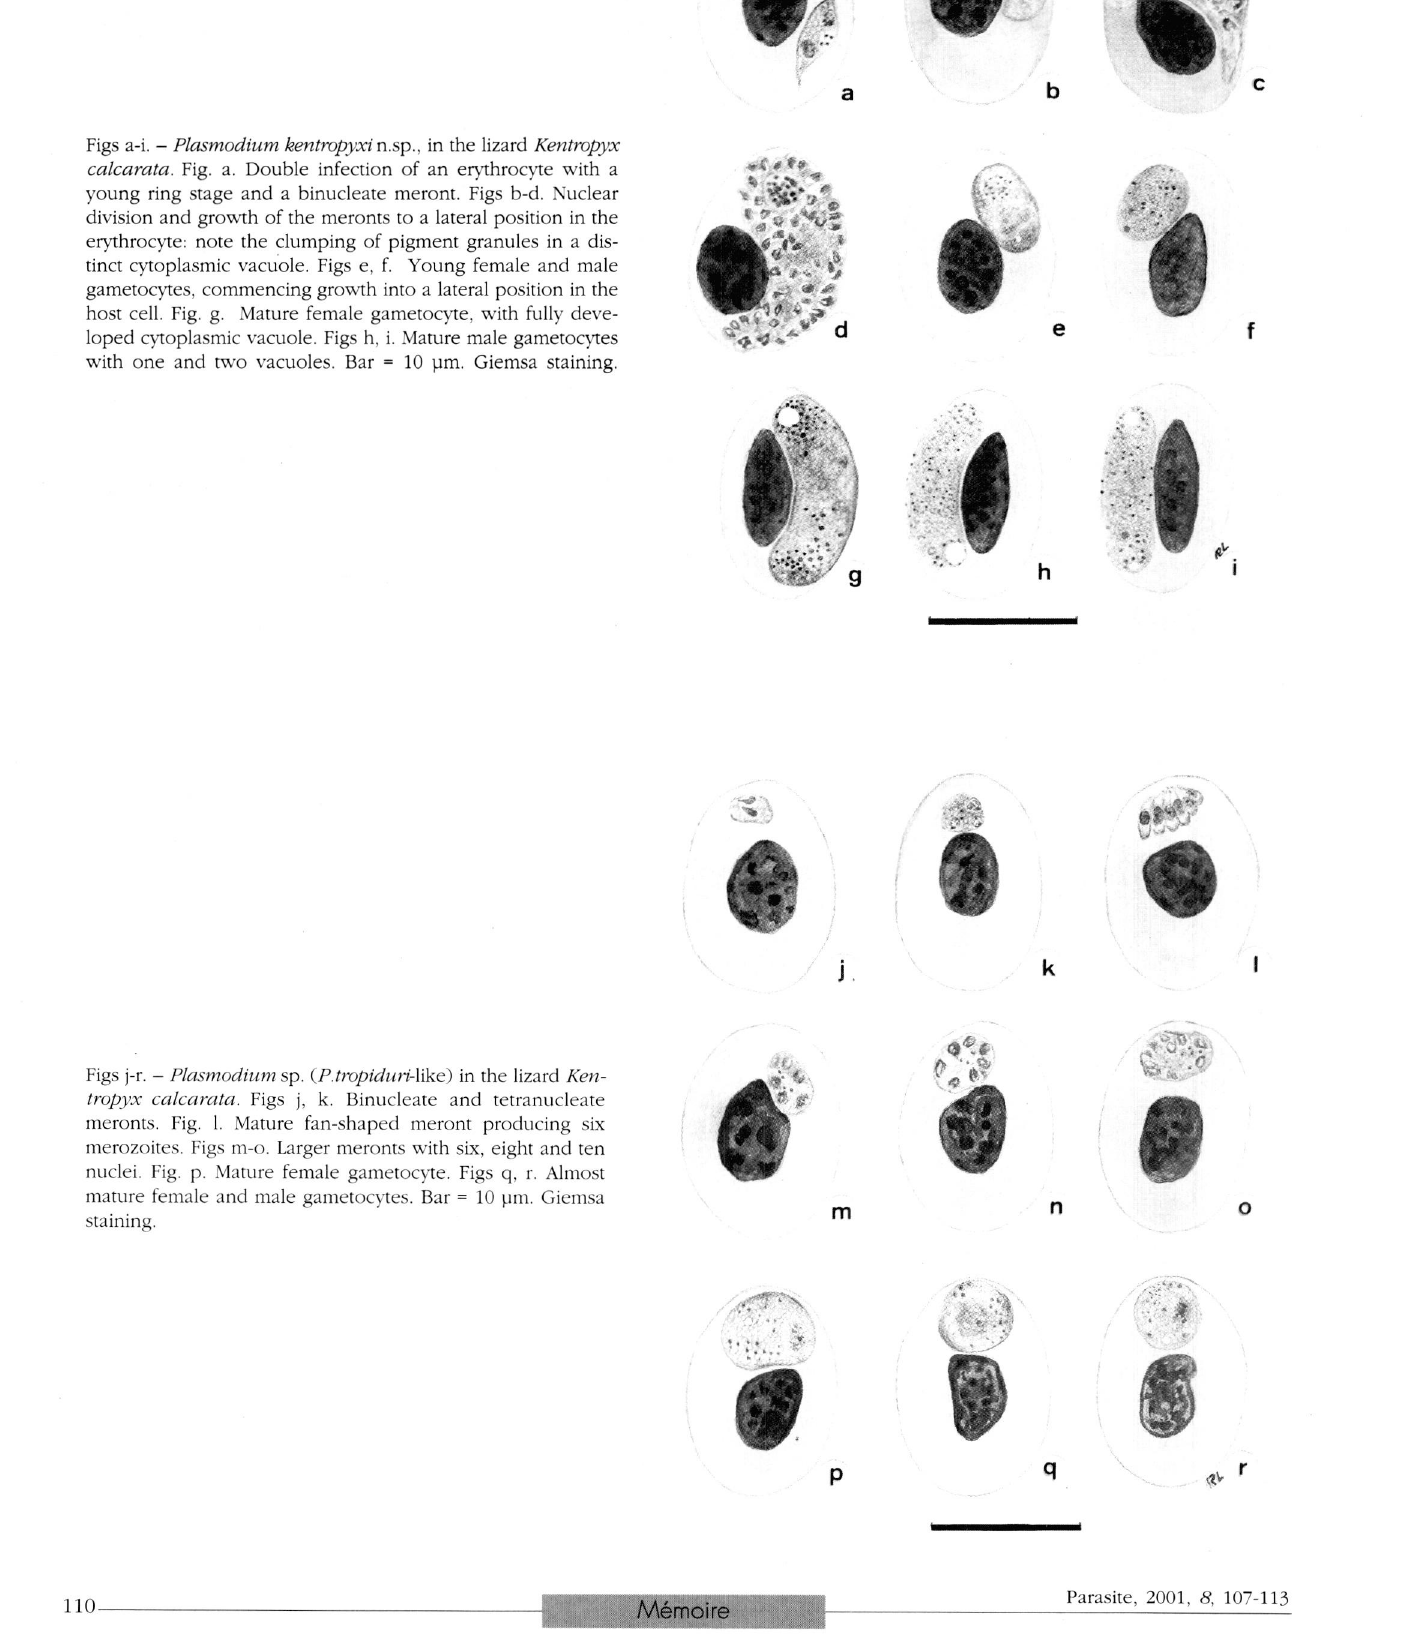
Figs a-i. - Plasmodium kentropyxi n.sp., in the lizard Kentropyx calcarata. Fig. a. Double infection of an erythrocyte with a young ring stage and a binucleate meront. Figs b-d. Nuclear division and growth of the meronts to a lateral position in the erythrocyte: note the clumping of pigment granules in a dis­ tinct cytoplasmic vacuole. Figs e, f. Young female and male gametocytes, commencing growth into a lateral position in the host cell. Fig. g. Mature female gametocyte, with fully deve­ loped cytoplasmic vacuole. Figs h, i. Mature male gametocytes with one and two vacuoles. Bar - 10 um. Giemsa staining.